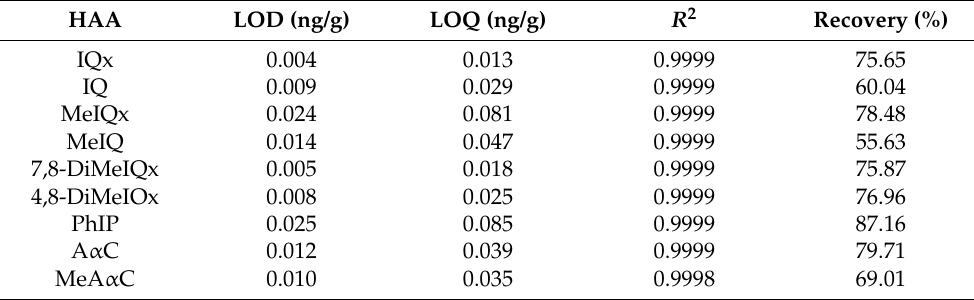
Table 3. LOD, LOQ, R 2 , and recovery values (n =